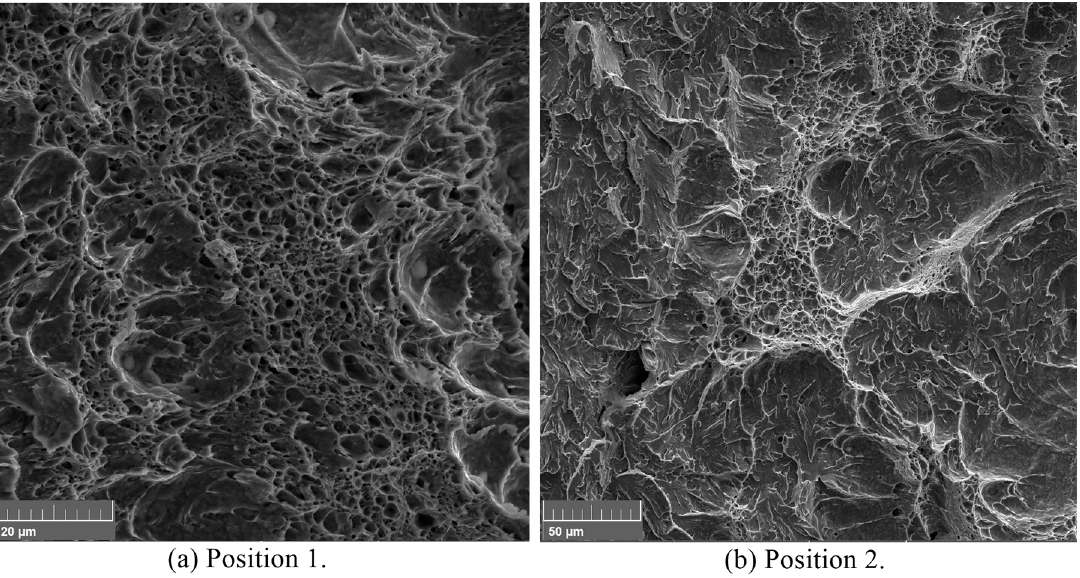
Figure 9. SEM fractographies, Charpy impact